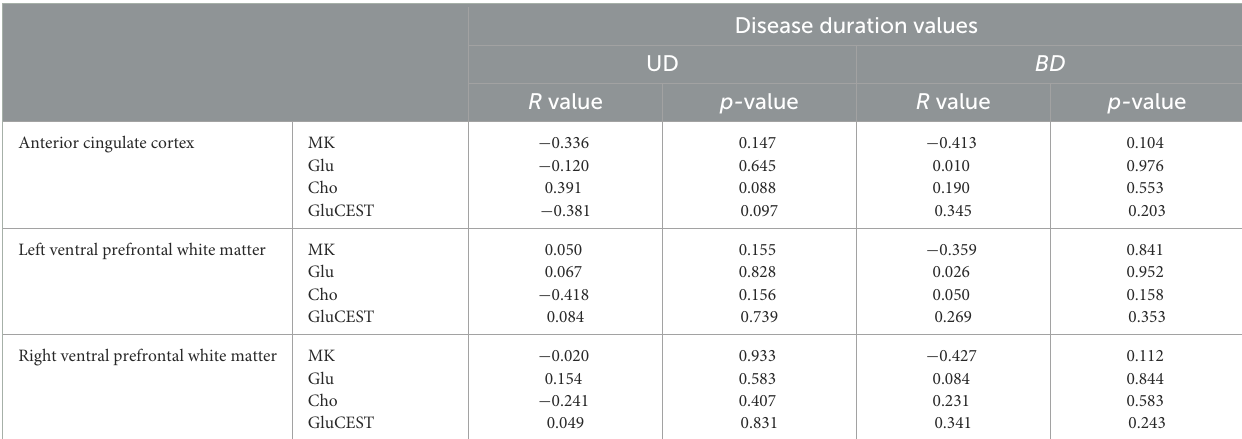
TABLE 2 Correlation between disease duration values and MRS, DKI, GluCEST parameters of anterior cingulate cortex and ventral prefrontal white